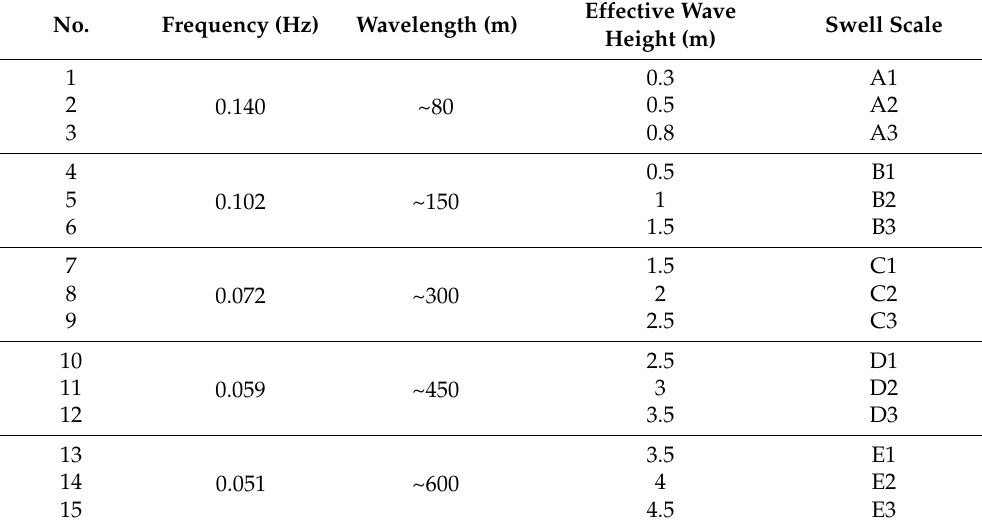
Figure 17. Variation in dimensionless U WD with wave age for different wind speeds, radar incidence angles of 6° and 12°, radar azimuth of 0°, wind direction of 0°, and no waves; solid line indicates downwind and dashed line indicates upwind.